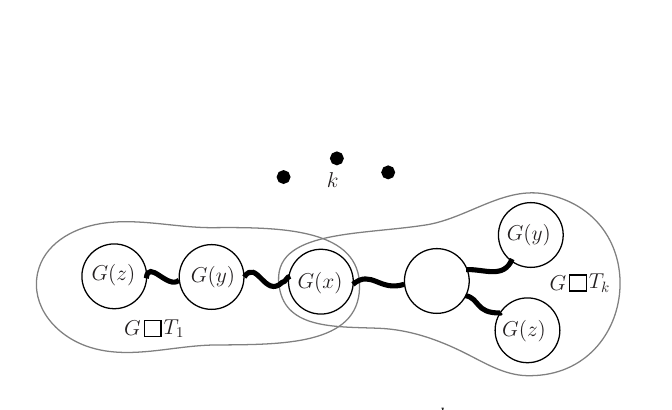
(cid:83) k T i . i =1 (cid:31)